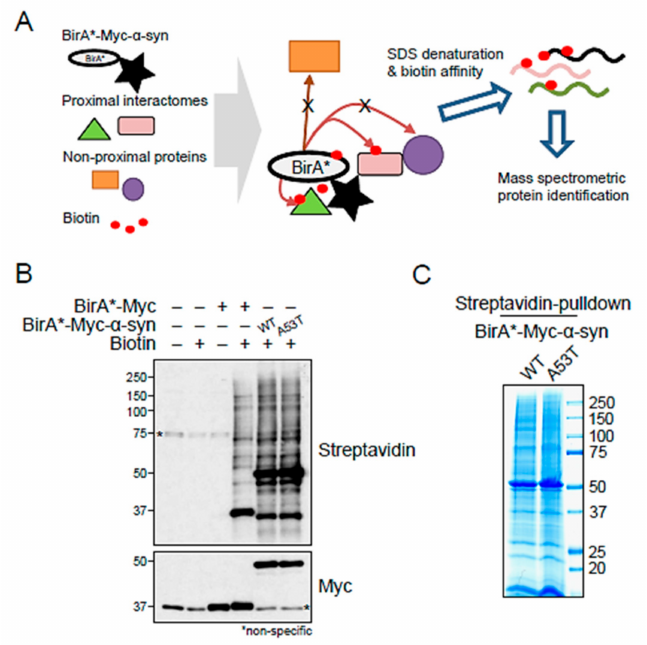
Figure 1. BioID-identified binding partners of α -syn. ( A ) Schematic image of BioID pulldown assay with BirA*-fused, Myc-tagged α -syn. ( B ) Biotinylated proteins were isolated and detected using a streptavidin antibody. * Non-specific band. ( C ) Representative image of biotin-labeled immunopre- cipitates of BirA*-fused, Myc-tagged α -syn WT and A53T visualized using Coomassie